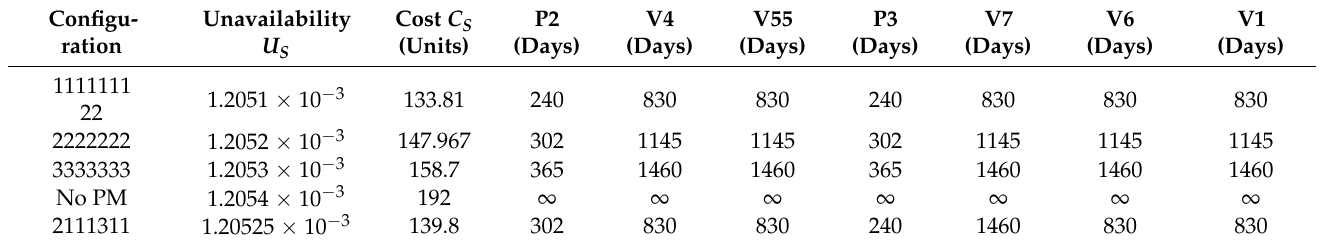
Table 4. Decision variable vectors (𝑇𝑃 1 ,… , 𝑇𝑃 𝑘 ) for the configurations of the full system version.